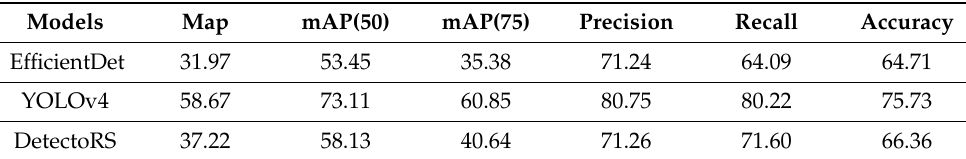
Table 3. Comparative performance of the deep learning models.